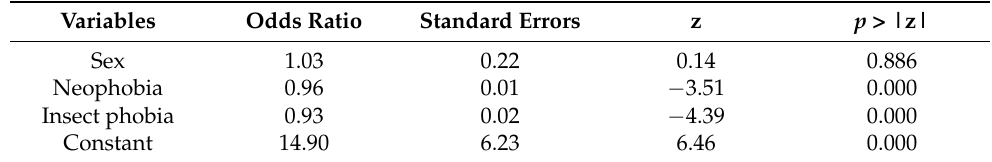
Table 6. Results of the first logit model (Model 1) of the probability to eat food that contains insects. Variables